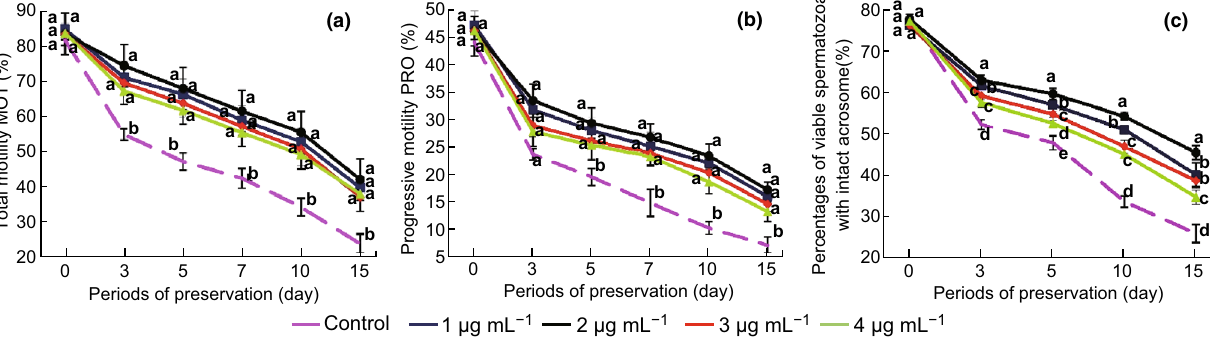
Fig. 1 Effects of carboxylated C 60 on motility, acrosome integrity, and mitochondrial membrane potential of boar semen preserved at 4 °C for half a month. a Sperm motility parameters (MOT), b progressive motility parameters (PRO), c acrosome integrity. Each experiment was per- formed at least six times and subjected to statistical analysis. Different lowercase letters within the same day demonstrate significant differences ( P < 0.05), whereas the same lowercase letters denote insignificant